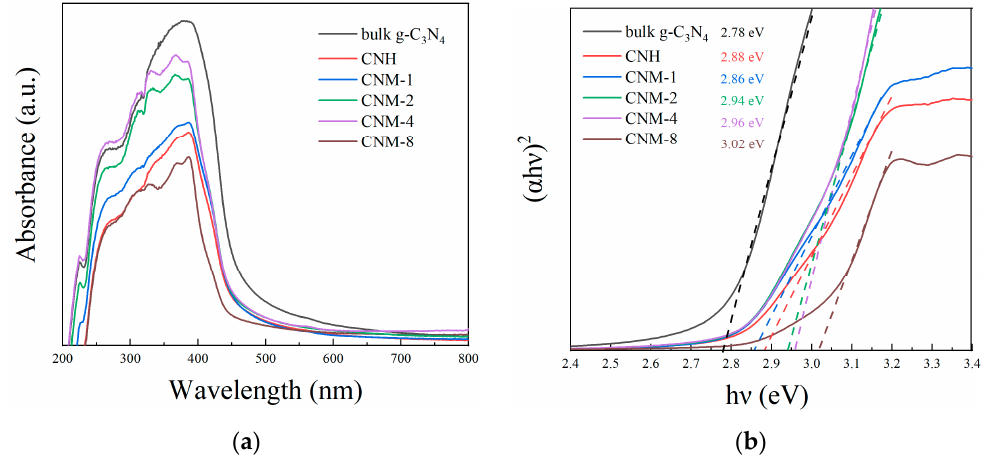
Figure 7. ( a ) UV-Vis absorption spectra of bulk g-C 3 N 4 , CNH, and all g-C 3 N 4 /MoO 2 composites, and ( b ) their corresponding (ah ν ) 2 versus E g plots.